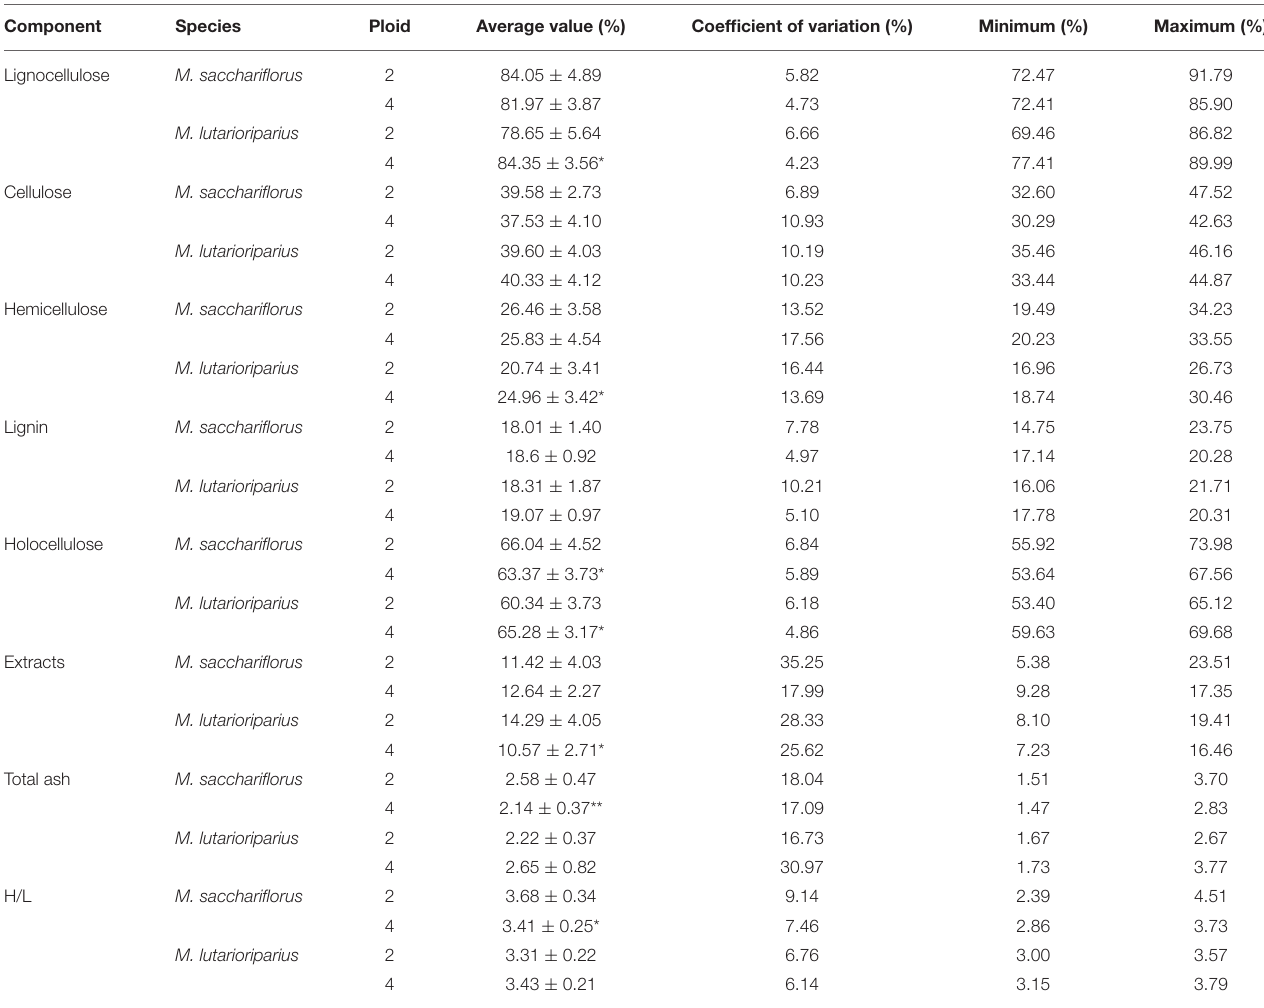
TABLE 3 | Statistical results of lignocellulose fractions of different ploidies of M. sacchariflorus and M. lutarioriparius . Component Species Ploid Average value (%) Coefficient of variation (%) Minimum (%) Maximum